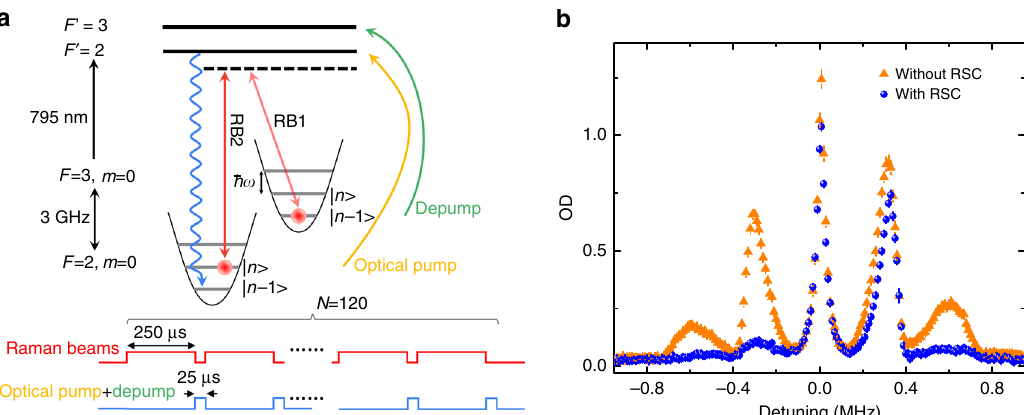
Fig. 2 Raman sideband cooling in the fi bre. a Energy levels and timing sequence. The energy levels represent the vibrational energy splitting of the optical lattice potential in the axial direction. The wavy blue arrow denotes the spontaneous emission of atoms. Each cooling cycle consists of 250 μ s of the Raman pulses (RB1 and RB2) and 25 μ s of the depump and optical pump pulses. The overall duration for the best cooling performance is N = 120 cooling cycles. RB1 and RB2 are detuned by 3 GHz − ω /2 π to reduce n by 1. b Vibrational spectra. We use RB1 and RB2 to excite atoms to the | F = 3, m = 0> state. The x axis is the detuning between the two Raman beams and is set at zero at the carrier transition frequency. We plot the OD for the | F = 3, m = 0> state as a function of the detuning with and without RSC. Most of the atoms are accumulated in the n = 0 state after RSC; therefore, the blue sidebands remain (mostly n = 0 to n = 1 transition), and the red sidebands are suppressed. Smaller OD after RSC is mainly due to atom loss during RSC. Error bars are the standard error of the mean of four experimental